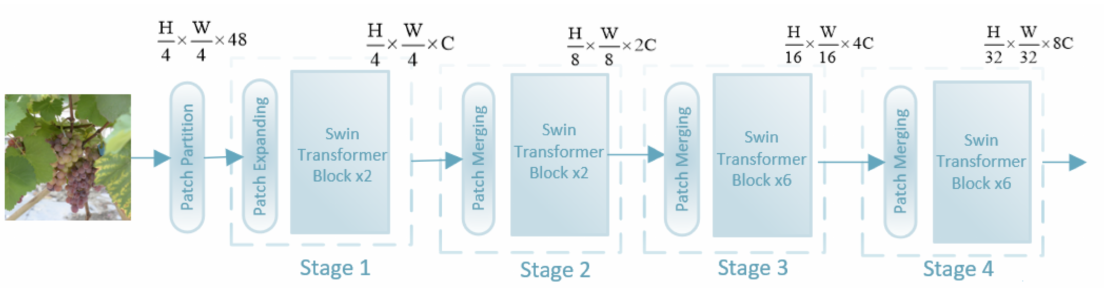
Figure 2. Swin transformer